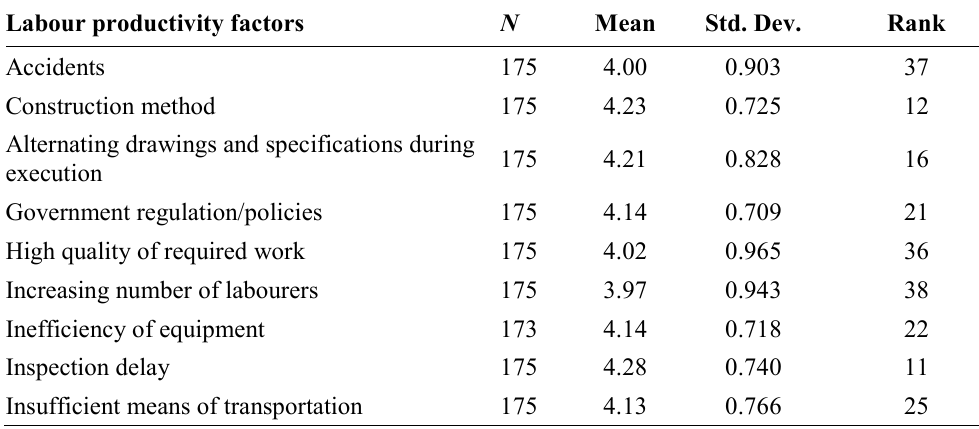
Table 2. Factors Affecting Labour Productivity in Construction Firms Labour productivity